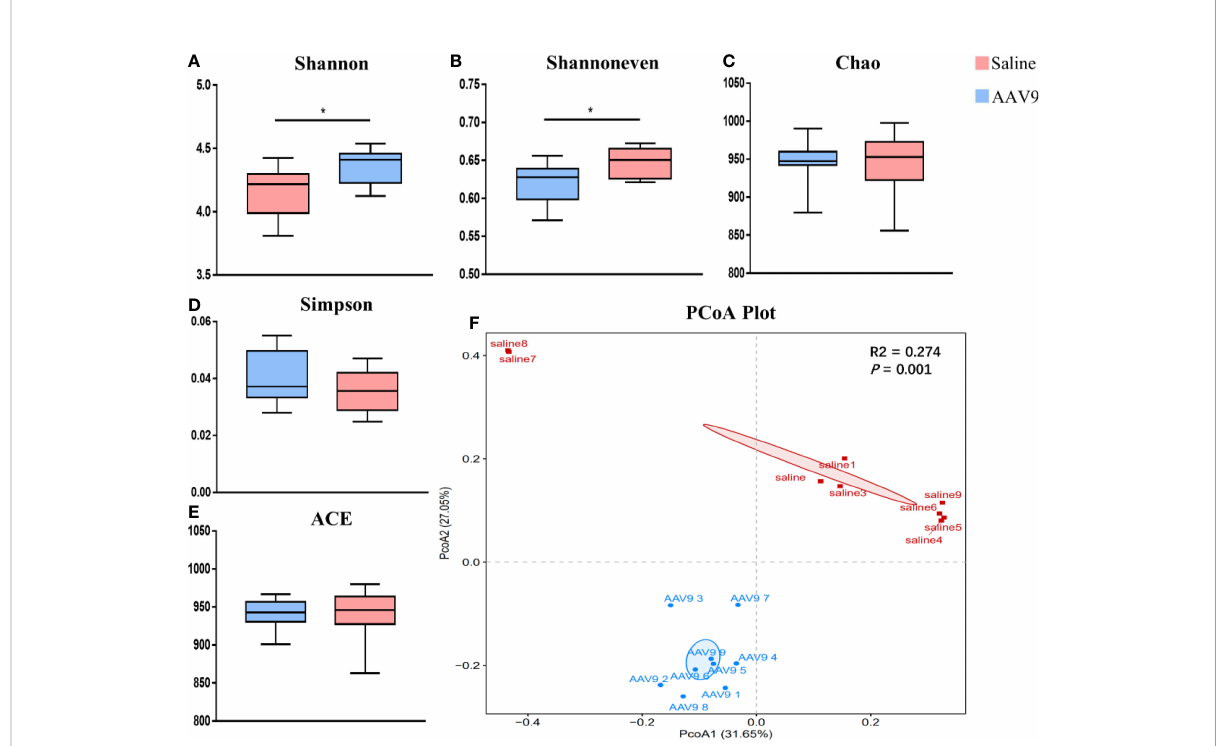
FIGURE 3 Comparison of the faecal microbiota compositions of the saline and AAV9 groups. (A) Shannon, (B) Shannon evenness, (C) Chao, (D) Simpson, (E) ACE. Each box plot represents the median, interquartile range, minimum, and maximum values. P values were determined using Student ’ s t test. (F) PCoA based on Bray – Curtis dissimilarity showed that the overall faecal microbiota composition was different between the saline and AAV9 groups (F. Model: 6.05, P = 0.001). * p <